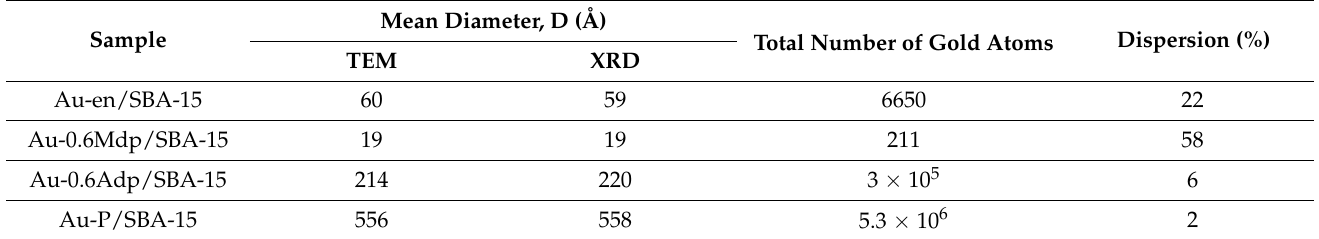
Table 2. Calculated total number of gold atoms and dispersion for the fresh